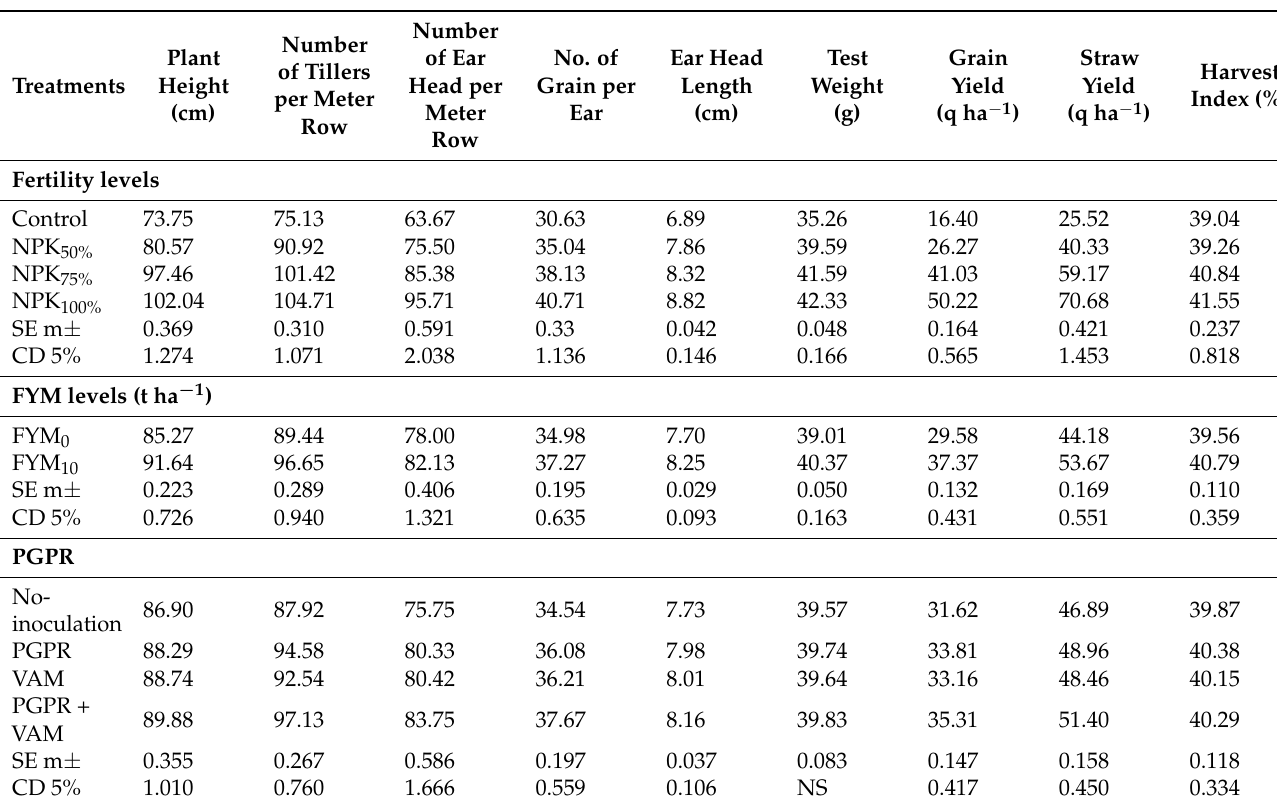
Table 2. Effect of various treatments on the growth, yield attributes, and yield of wheat (mean of two